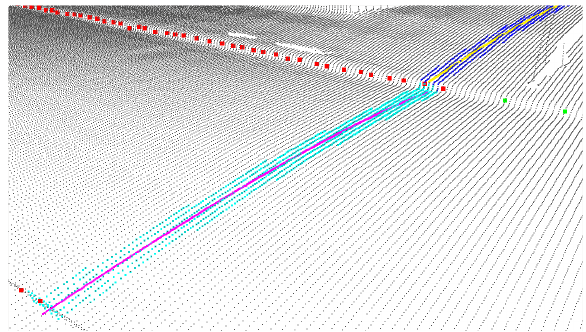
Figure 5: Points of the road around the slice in light blue. Points of a walking area around the slice in deep blue. Road and walking area surface modeling respectively in purple and yellow.